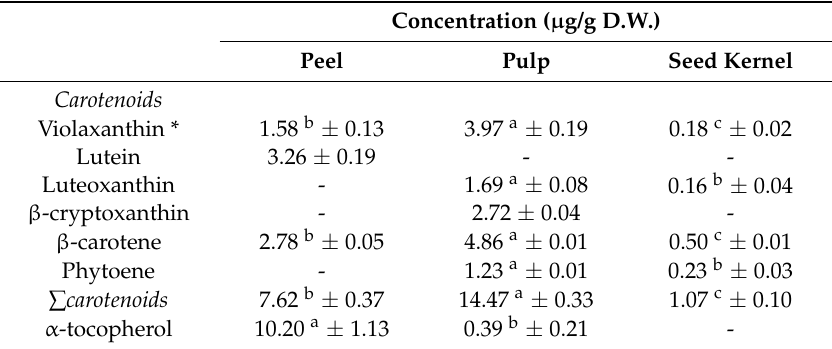
Table 1. Isoprenoid, carotenoids and α -tocopherol, composition in mango organs (peels, pulps and seed kernels).